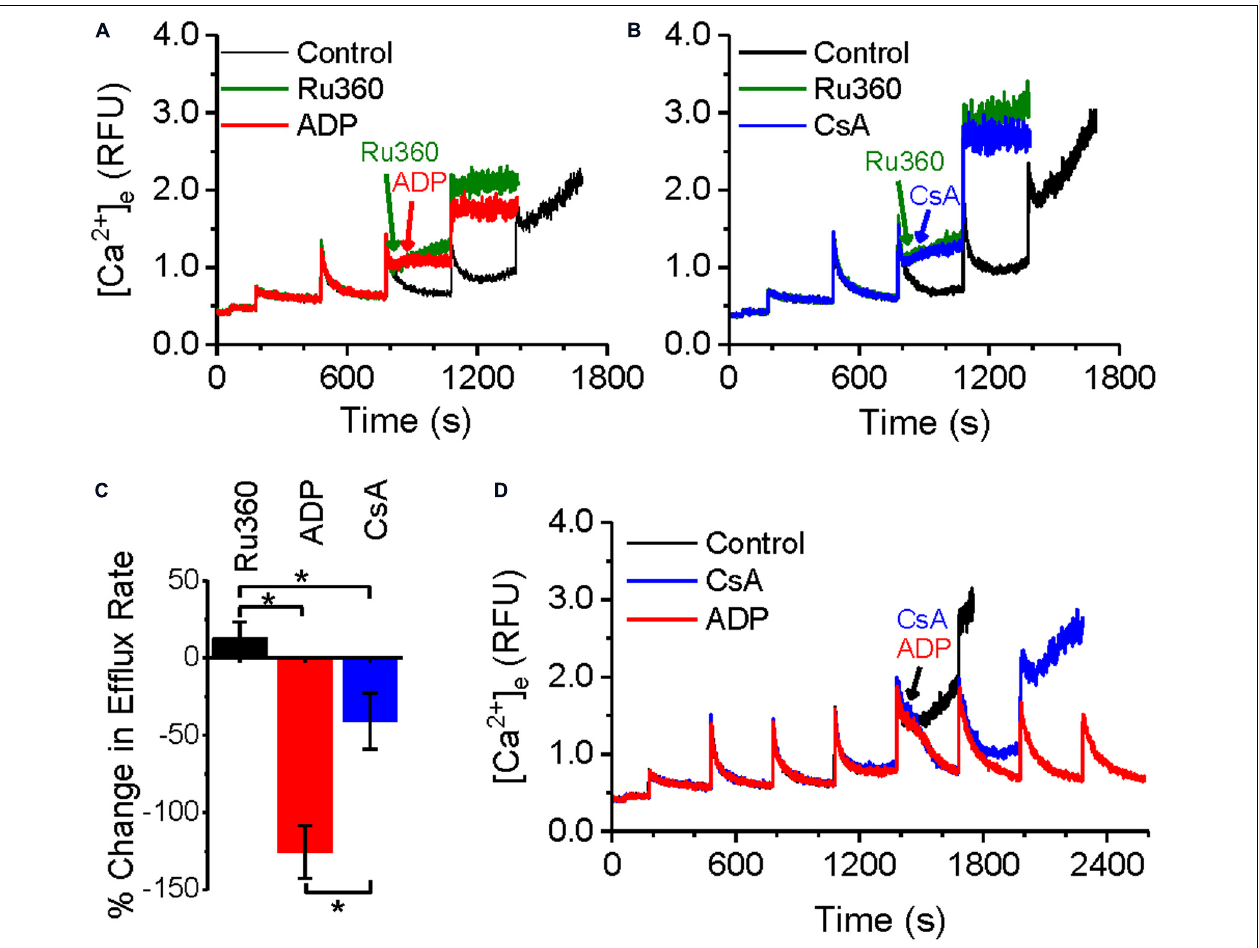
FIGURE 3 | Effect of ADP and CsA on Ca 2 + -efflux and mPTP opening. (A–C) Representative raw traces of extra-matrix Ca 2 + measured as relative fluorescence changes in Na + -free experimental buffer loaded with the Ca 2 + -sensitive ratiometric dye Fura-4F. 20 µ M CaCl 2 pulses were given at 180 and 480 s, followed by 1 µ M Ru360 at 800 s (green trace), and (A) 250 µ M ADP at 860 s or (B) 0.5 µ M CsA at 860 s. (C) % change in the efflux rate before and after addition of 1 µ M Ru360 ( n = 9), 250 µ M ADP ( n = 6) or 0.5 µ M CsA ( n = 4). * indicates significant difference ( p < 0.05) between indicated pairs. (D) Rescue of mPTP opening in Control (black trace) after addition of 250 µ M ADP (red trace) or 0.5 µ M CsA (blue